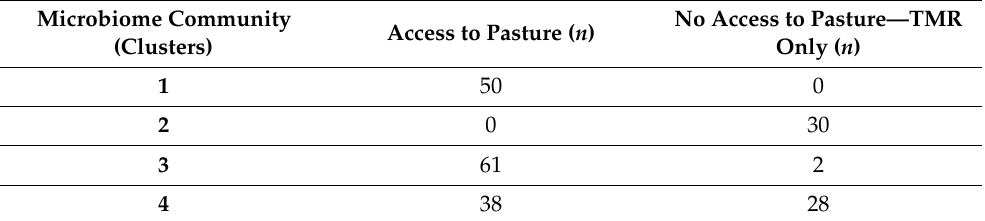
Table 5. Microbiome community membership relative to being fed solely a TMR or having access to pasture.